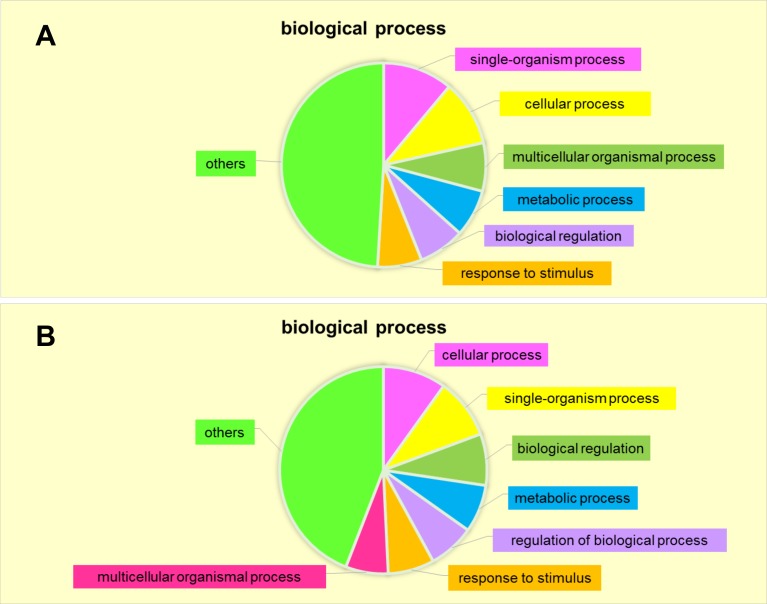
Biological processes enriched based on DPC-secreted proteins.(A) Up-regulated in passage 3 DPC-CM. (B) Down-regulated in passage 3 DPC-CM.